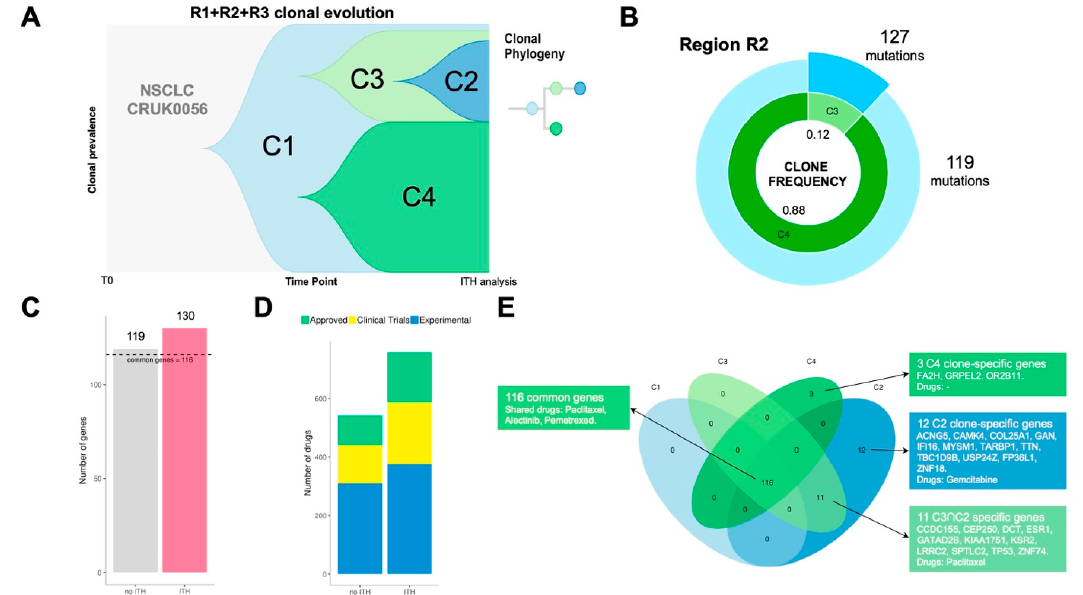
Figure 4. Analysis of the non-small cell lung cancer (NSCLC) patient CRUK0056. Three regions (R1, R2 and R3) were sampled and four different clones (C1, C2, C3 and C4) were detected in this patient.